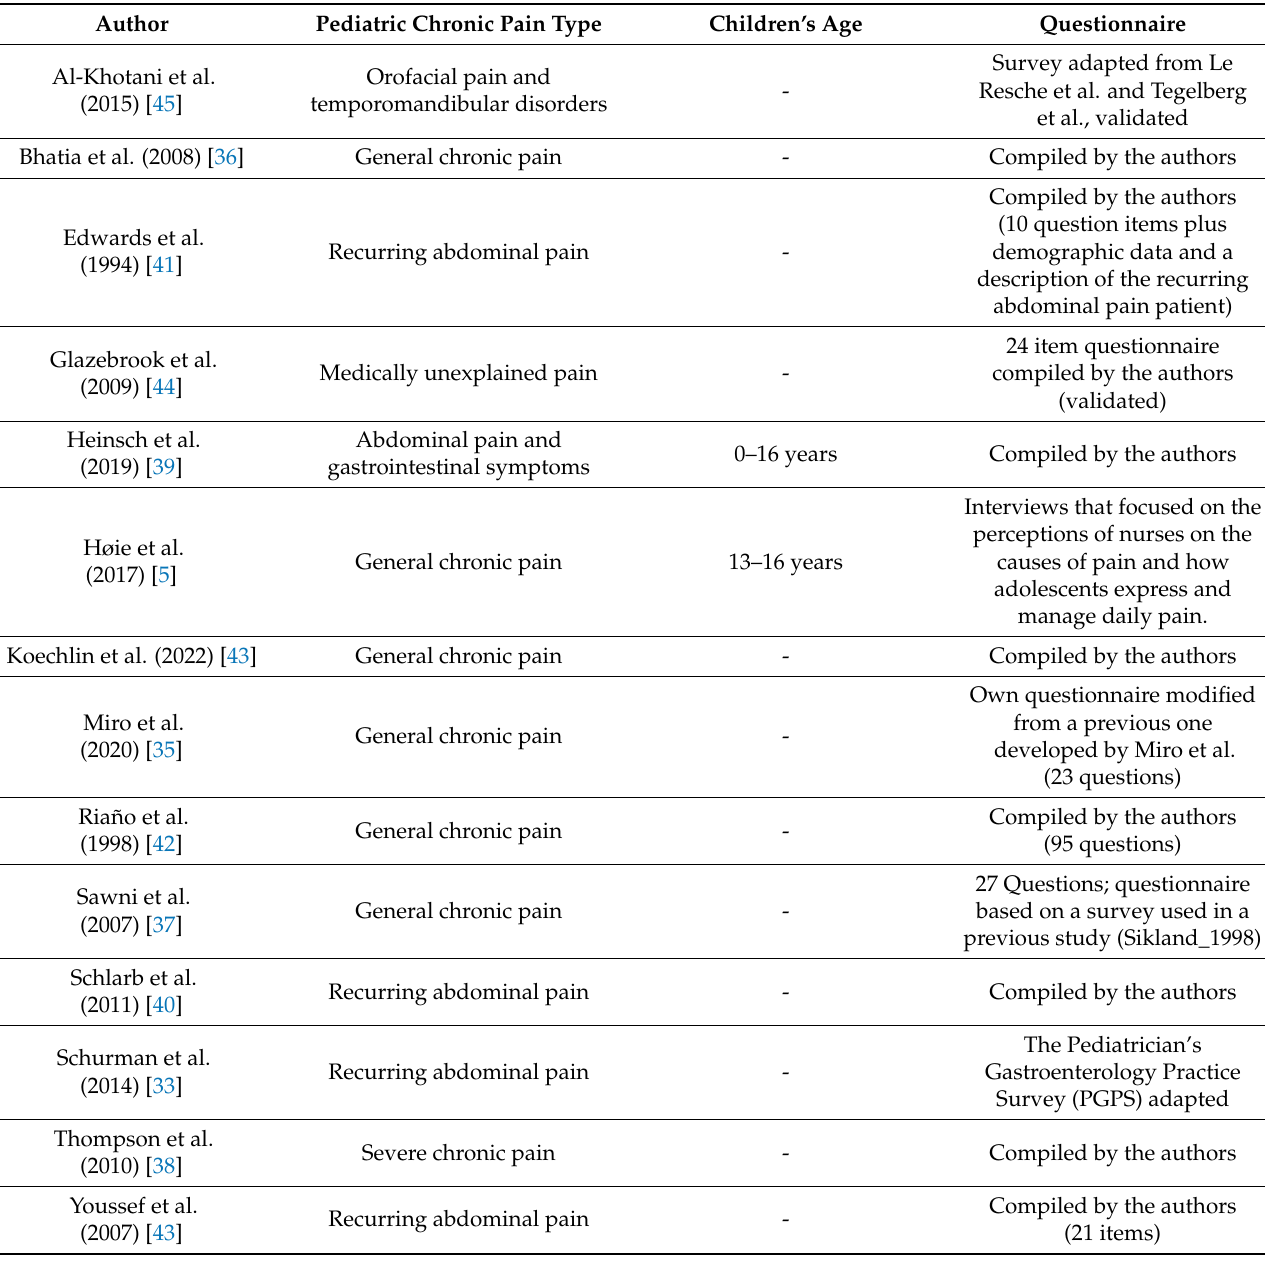
Table 3. Questionnaires used in each clinical trial to assess the knowledge of the health professionals involved in the management of pediatric chronic